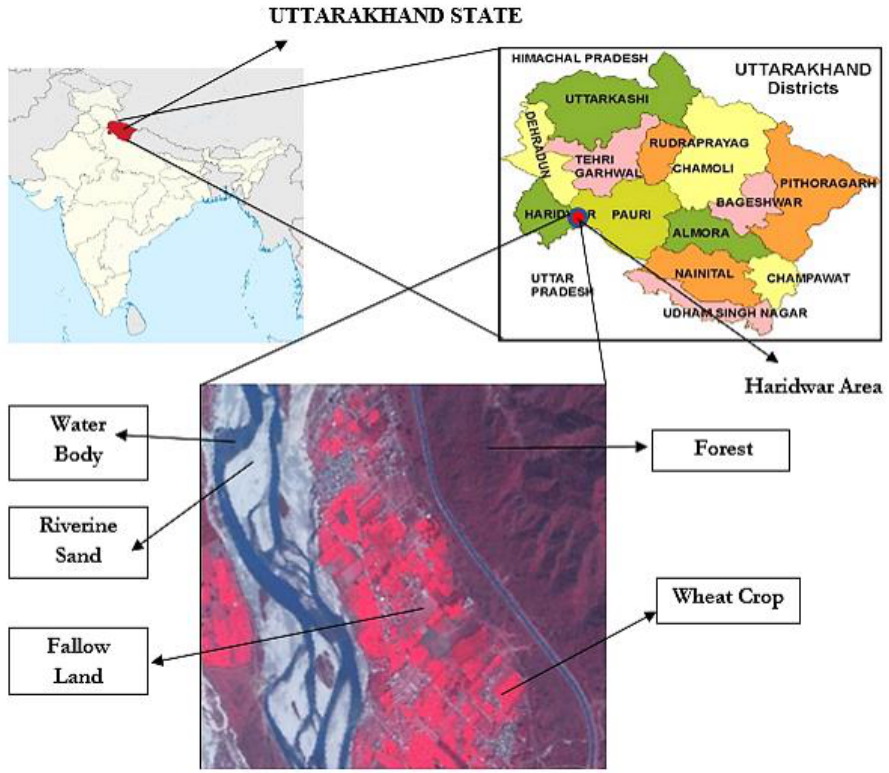
Figure 3. Infrared image is of Haridwar area, Uttarakhand, India showing the different land-use classes.